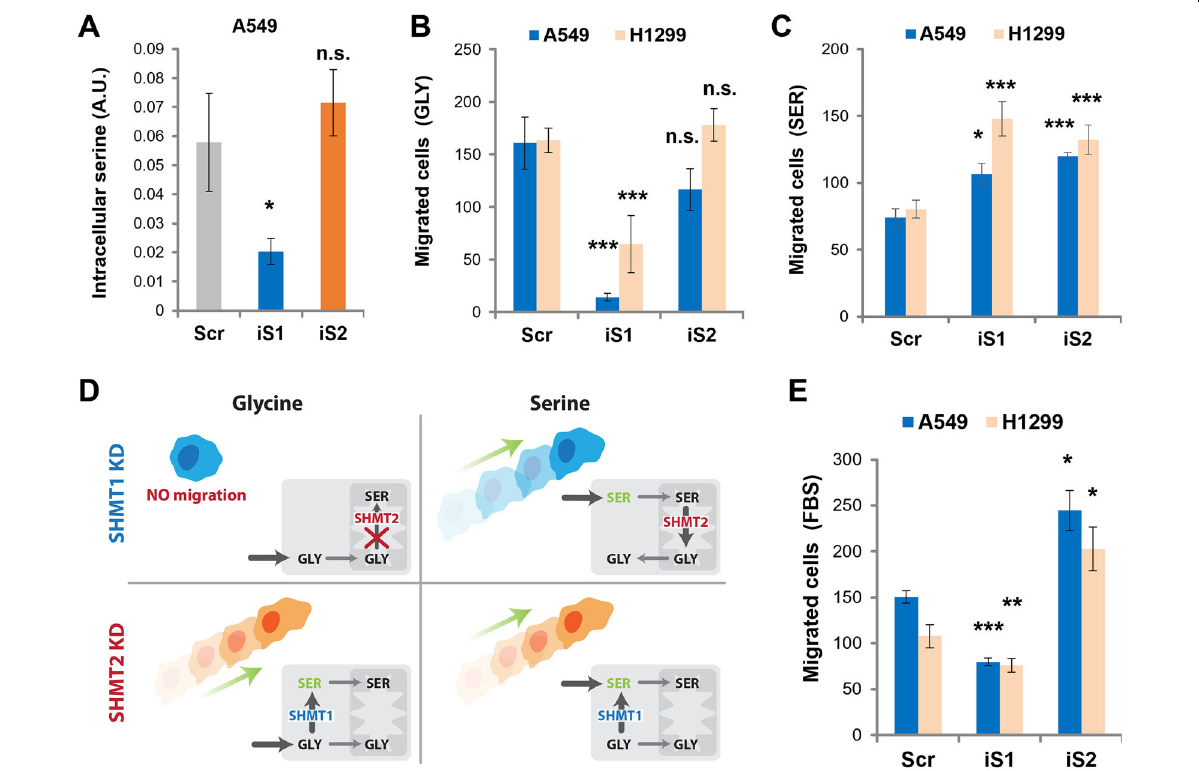
Fig. 3 SHMT1 controls glycine-to-serine cytosolic interconversion and affects cell migration. A Intracellular serine produced in A549 cells transfected with siRNA against either SHMT1 (iS1) or SHMT2 (iS2) measured by gas-MS, as compared to cells transfected with a scramble sequence control (Scr) and grown for 48 h in MEM supplemented with 400 μ M Gly and 500 μ M Formate ( n = 3). Migration test toward Gly ( B ), Ser ( C ), or FBS ( E ) was carried out with A549 cells transfected as indicated. The graphs represent three experimental replicates ( n = 3 for all the experiments). D Scheme summarizing the results obtained by knocking down SHMT1 (SHMT1 KD) or SHMT2 (SHMT2 KD) on cytosolic Ser levels and cell